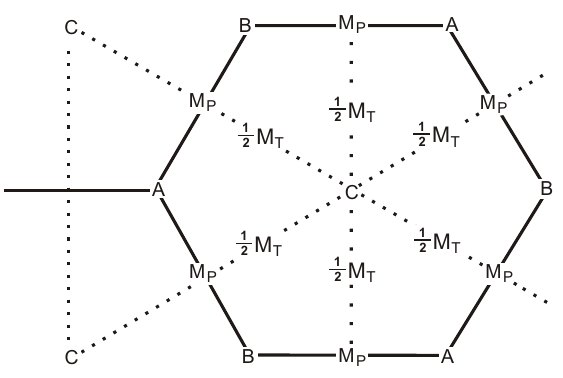
Figure 3. C points are primary cell centers or triangular momentum cell corners. A and B points are primary cell corners or momentum cell centers. Quadrilaterals are the intersection area between pri- mary and momentum cells. Arc intersection D points are overwrit- ten by M P in the diagram. D is halfway between C points but not halfway between A and B. Mass flux M P along a primary cell edge is computed and not changed; it is partitioned to each quadrilateral edge proportional to arc length. Change in mass of a primary cell by advection is computed by summing M P along the cell’s edges. This total change is partitioned into each quadrilateral of the cell propor- tional to area. The initial value of mass flux M T is computed along each momentum cell edge; half of M T is attributed to each primary cell through which it passes. In each primary cell, the half M T val- ues are adjusted minimally so that the sum of the mass fluxes into each quadrilateral matches the quadrilateral’s expected partitioned change. Each final M T is equal to the sum of the two adjusted “half” M T